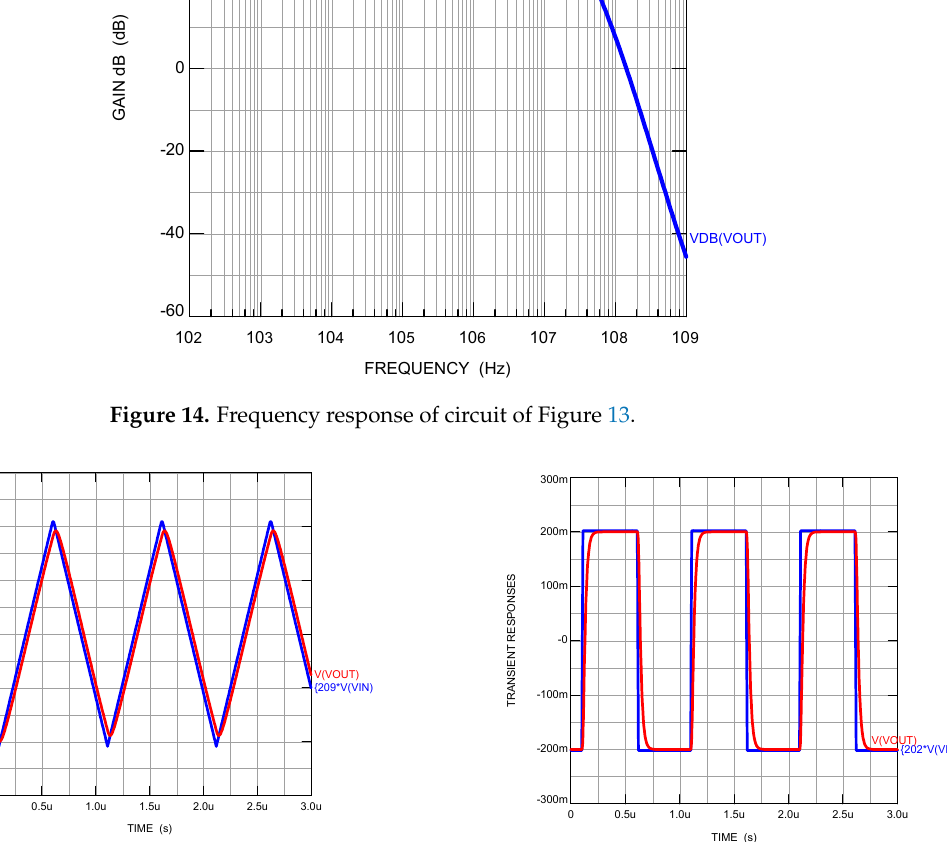
Figure 15. Transient response of circuit of Figure 13 ( a ) with triangular input signal, ( b ) with pulse input signal.